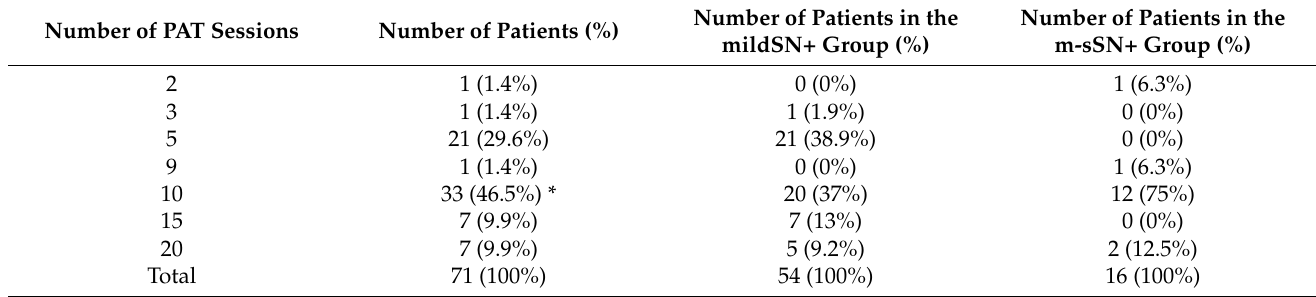
Table 2. Frequency of PAT